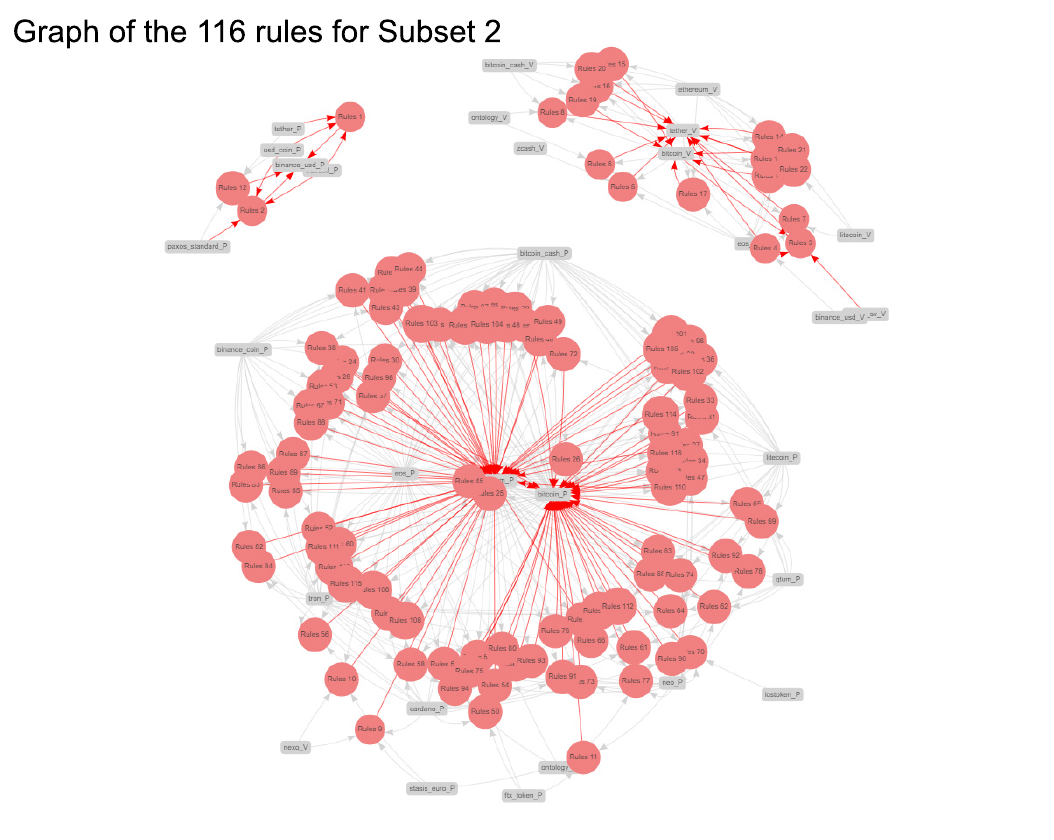
Figure 11. Directed graph of the 116 rules for Subset